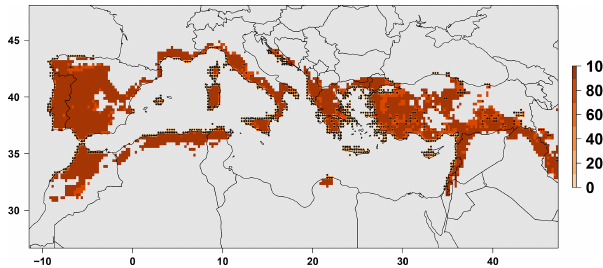
Figure 2. Percentage of available monthly soil moisture values from 1999–2019. All grid points excluded from this study are marked with a